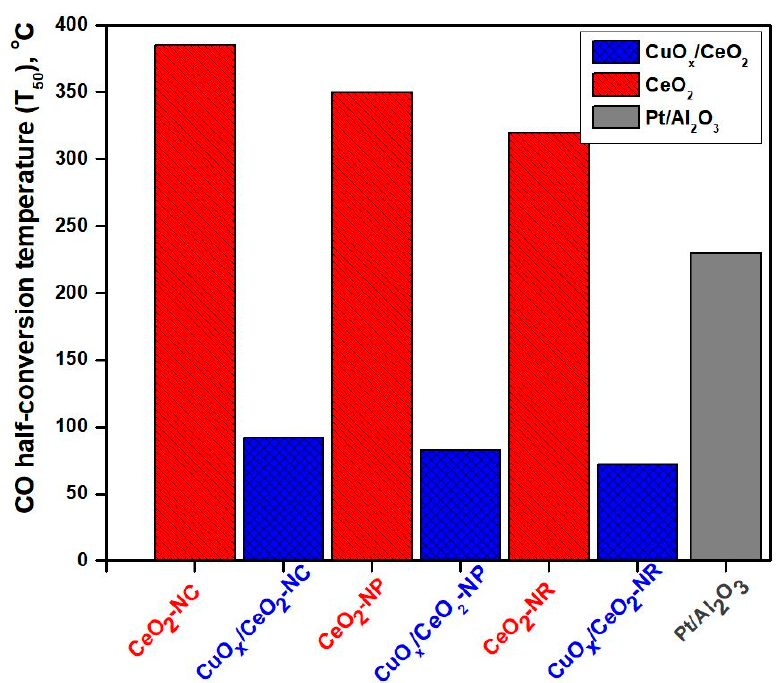
Figure 12. A comparison between bare ceria, copper-ceria and a noble metal catalyst, in terms of half-conversion temperature (T 50 ) for the oxidation of CO. Reaction conditions: 2000 ppm CO, 1 vol.% O 2 , GHSV = 39,000 h − 1 .